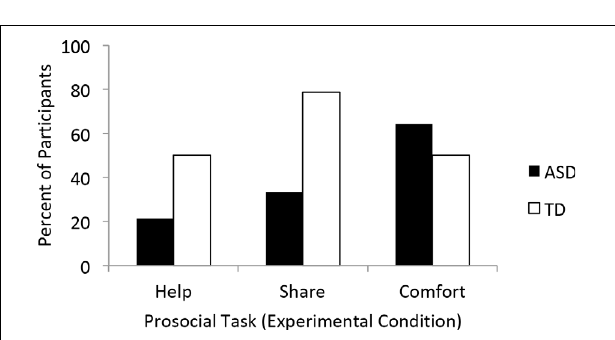
FIGURE 2 | Comparison of prosocial behavior in the experimental condition across the three varieties of need (instrumental, material, and emotional) by group. These bars reflect 10 s response periods for helping and sharing and a 30 s response period for comforting.